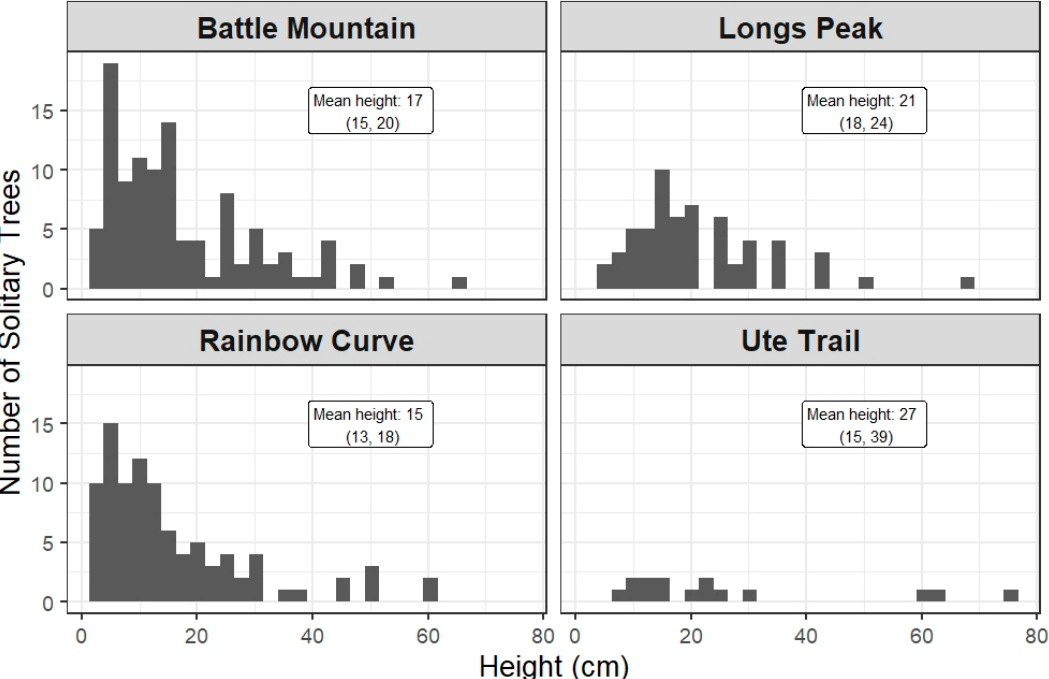
Figure 3. Solitary tree heights are displayed for the four study sites. Mean height (cm) and 95% confidence intervals are displayed in the text boxes. Where confidence intervals do not overlap, differences are significant at the α = 0.05 threshold.